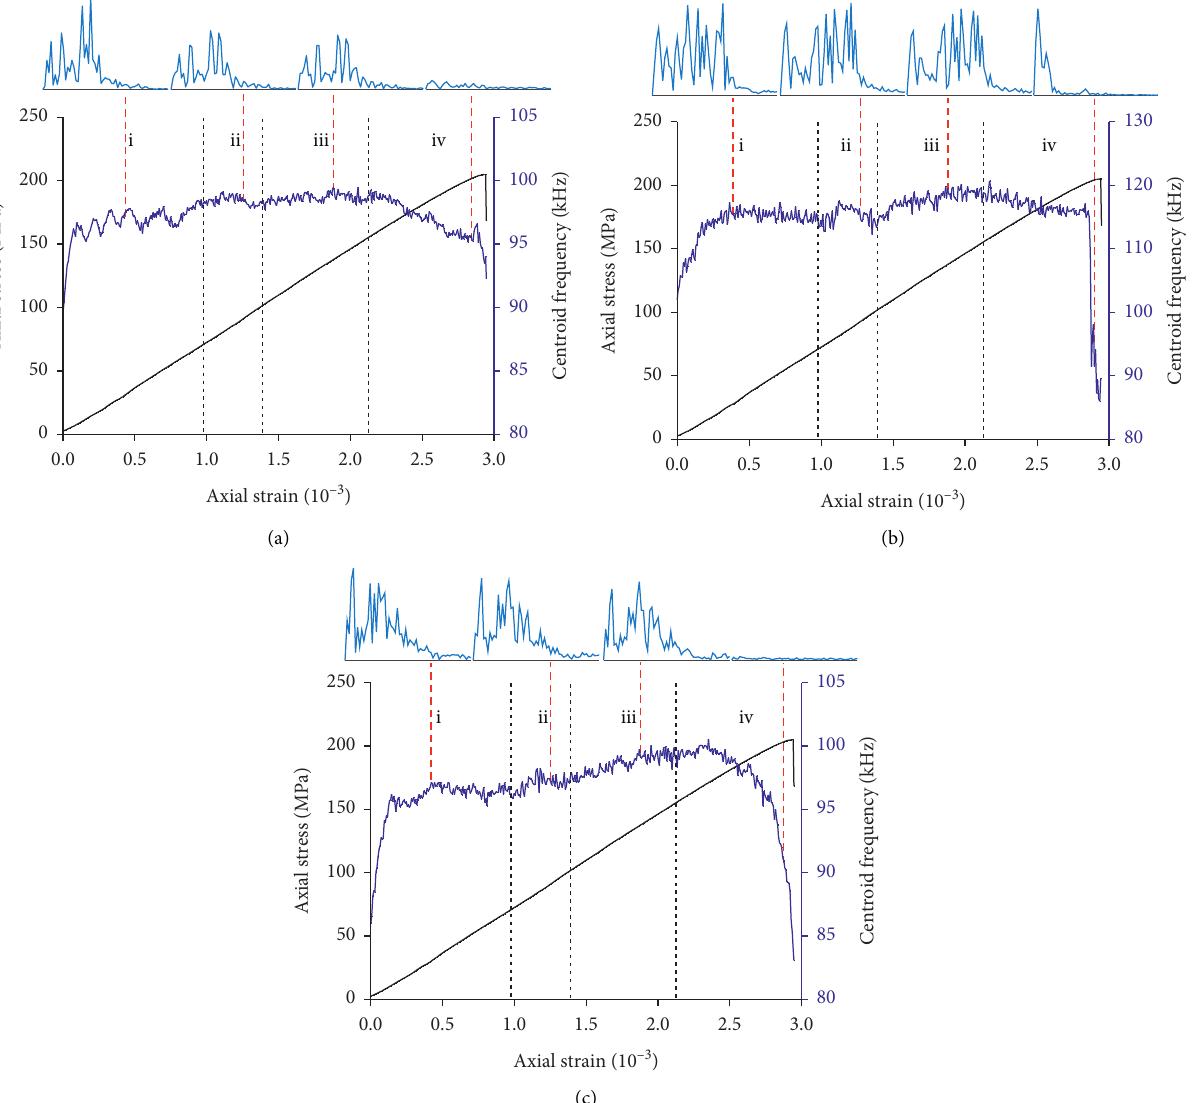
Figure 9: Centroid frequency and amplitude–frequency characteristics of granite sample at three locations under uniaxial loading: (a) CH2; (b) CH3; and (c)